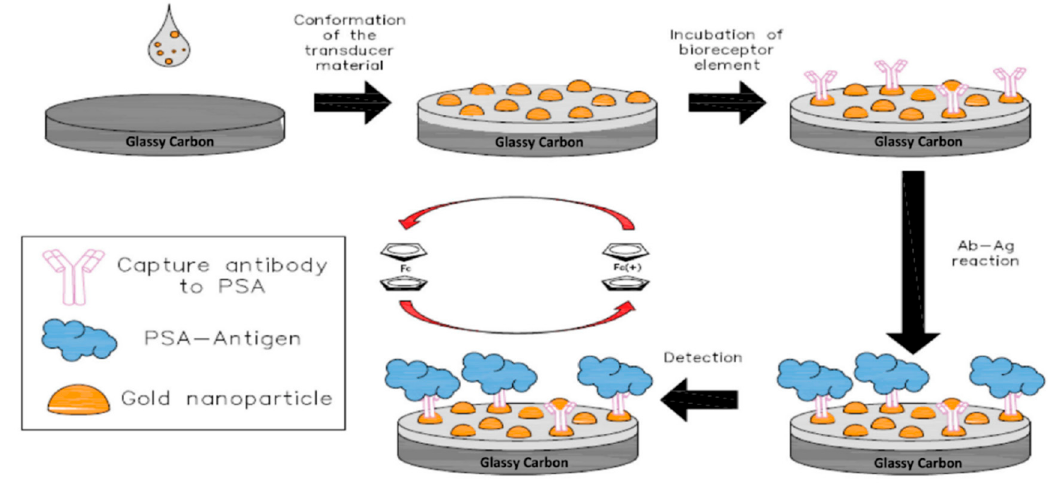
Figure 14. ECB for the detection of prostate specific antigen (PSA). PSA antibody was immobilized on the AuNP–functionalized MWCNT / GCE system that selectively interacted with the PSA–antigen [141]. Reprinted with permission from [141], Copyright © 2020 Published by Frontiers.